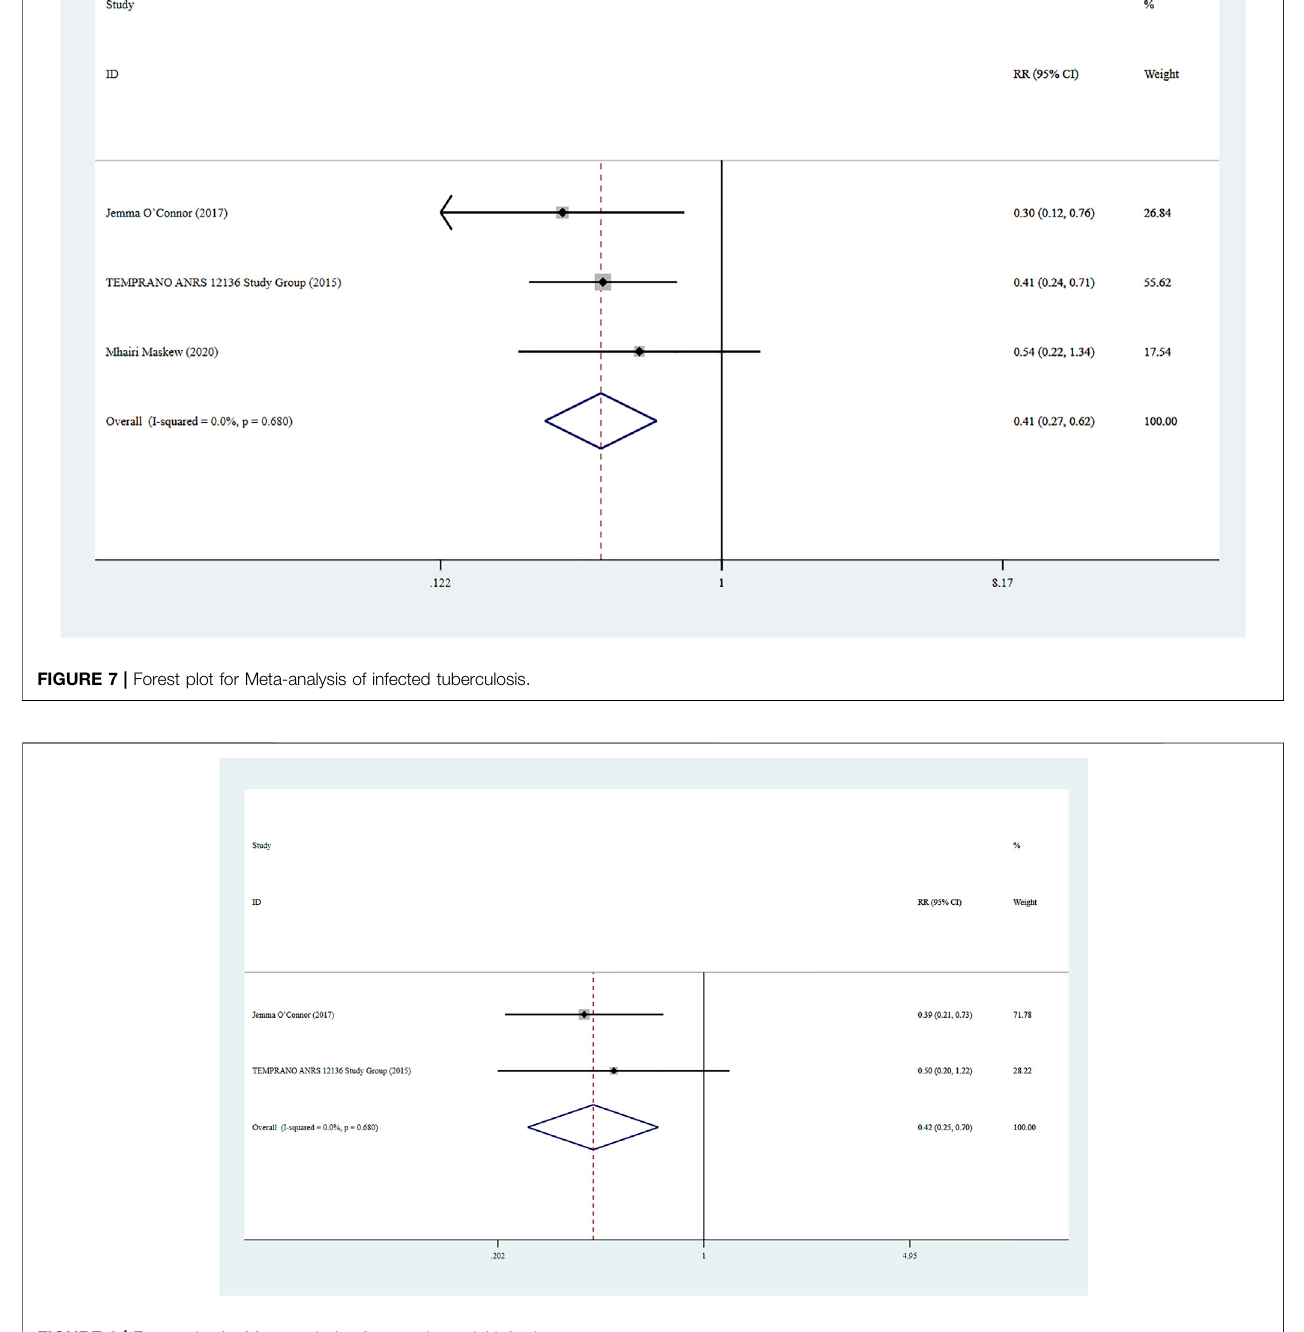
FIGURE 8 | Forest plot for Meta-analysis of severe bacterial infections.